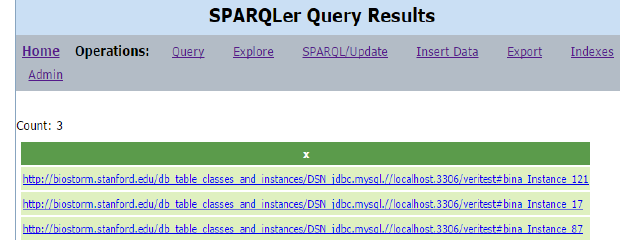
Figure. 3. Result of the first query.